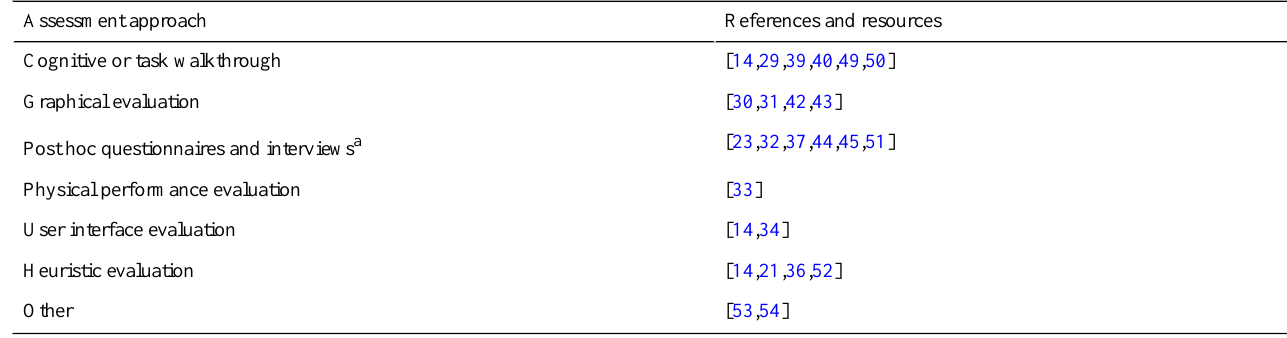
Table 2. Additional